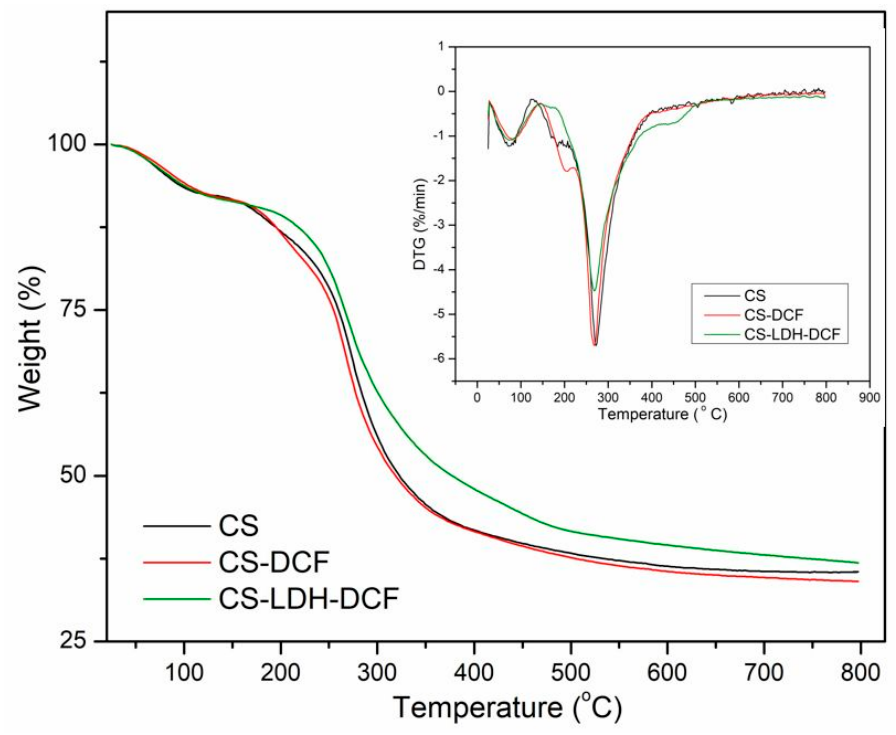
Figure 6. Thermal analysis of neat CS, CS-DCF, and CS-LDH-DCF.